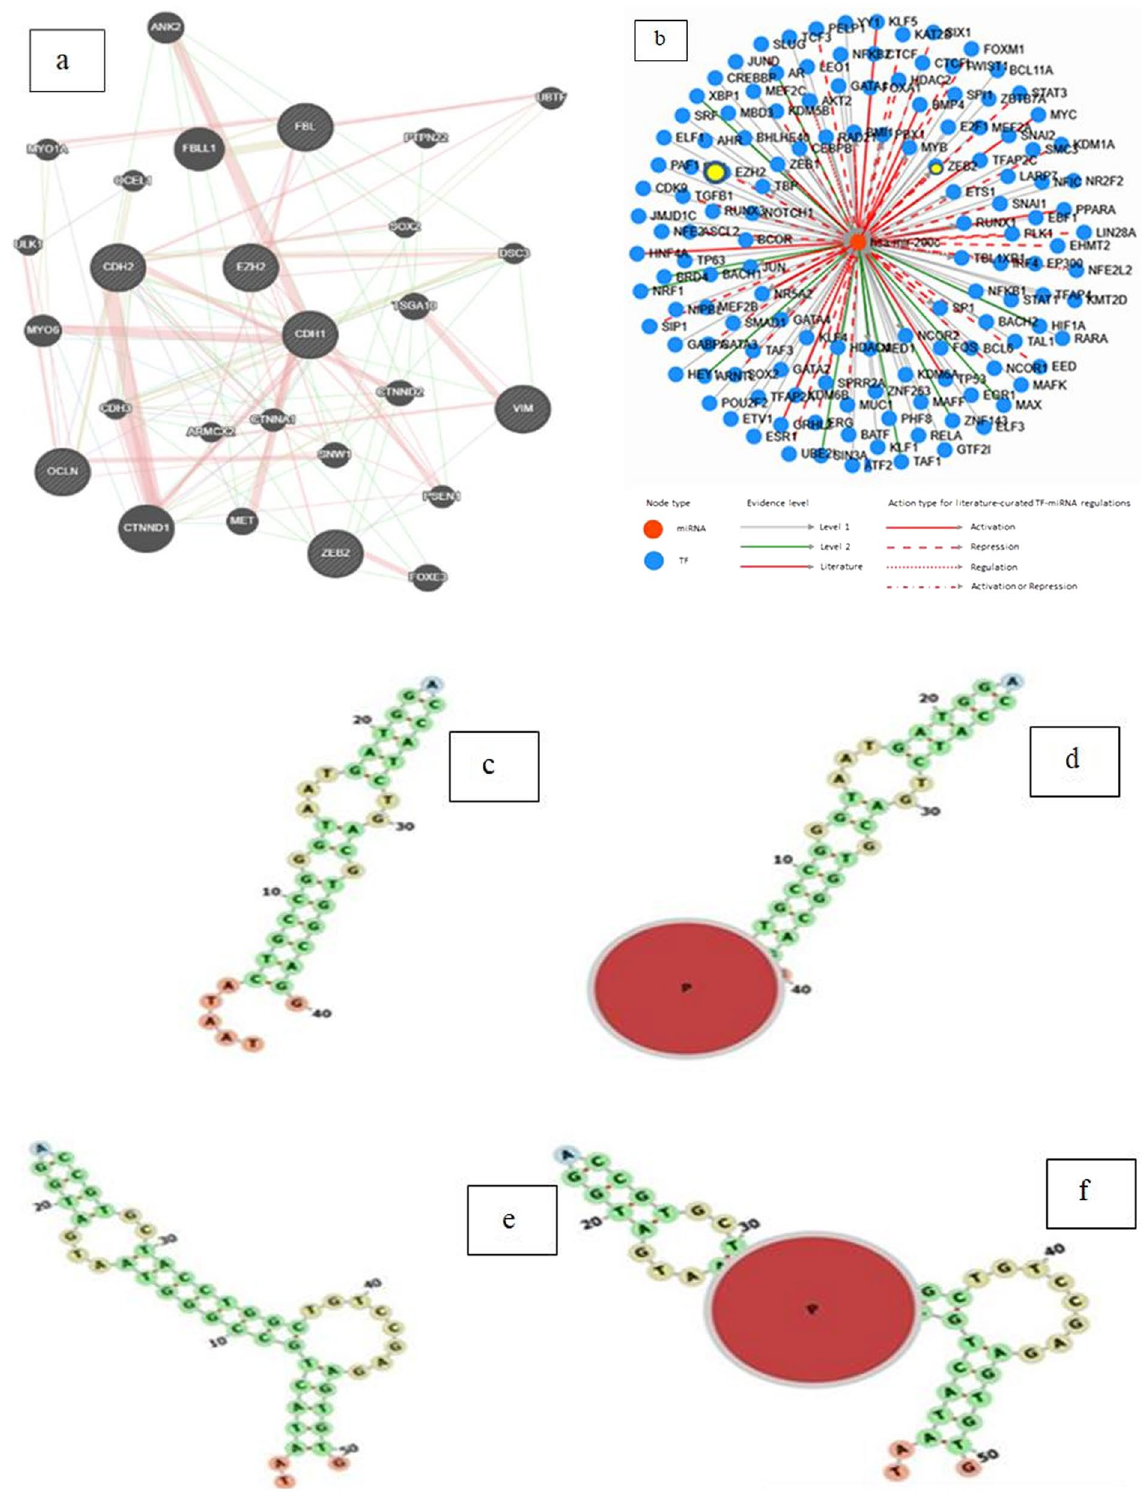
Figure 2. ( a ) The predicted protein–protein interaction network based on GeneMANIA. Predicted: predicted EZH2 relationships via EMT genes. ( b ) The image of interacted transcription factors with miR-200c which predicted by TransmiR database (http:// www. cuilab. cn/ trans mir) network. ( c ) 3D image of has-miR200c-3p A form. ( d ) 3D image of has-miR200c-3p and interaction between EZH2 protein and TAATA 5 ʹ end of